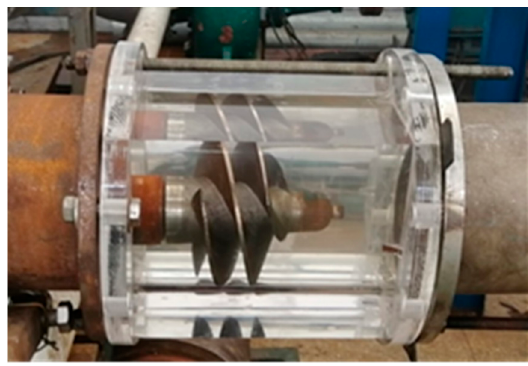
Figure 4. Transparent sleeve.